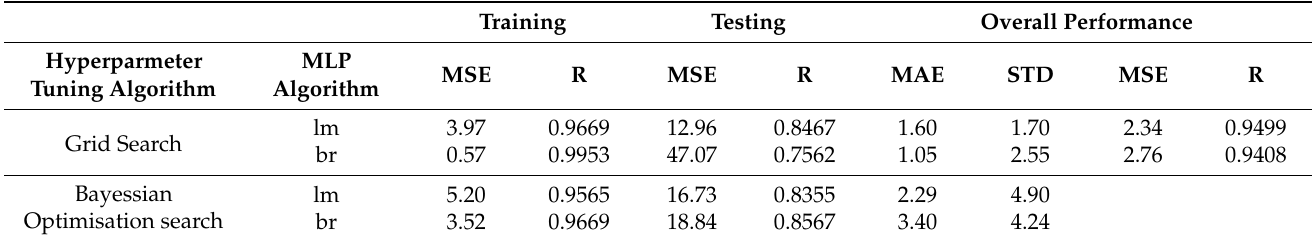
Table 6. Comparison of Hyperparameter Tuning algorithm performance with Grid Search and Bayesian Optimisation search.